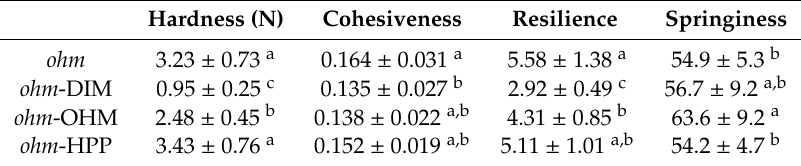
Table 1. Textural parameters of peach cubes.